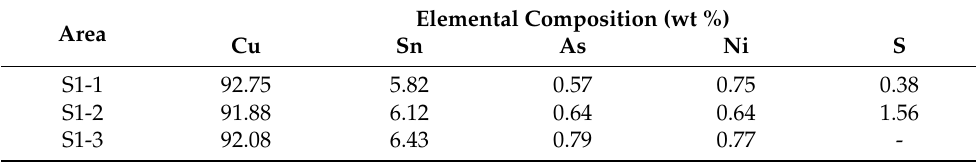
Table 1. Elemental chemical composition of the base alloy in the three areas of the S1 sample.